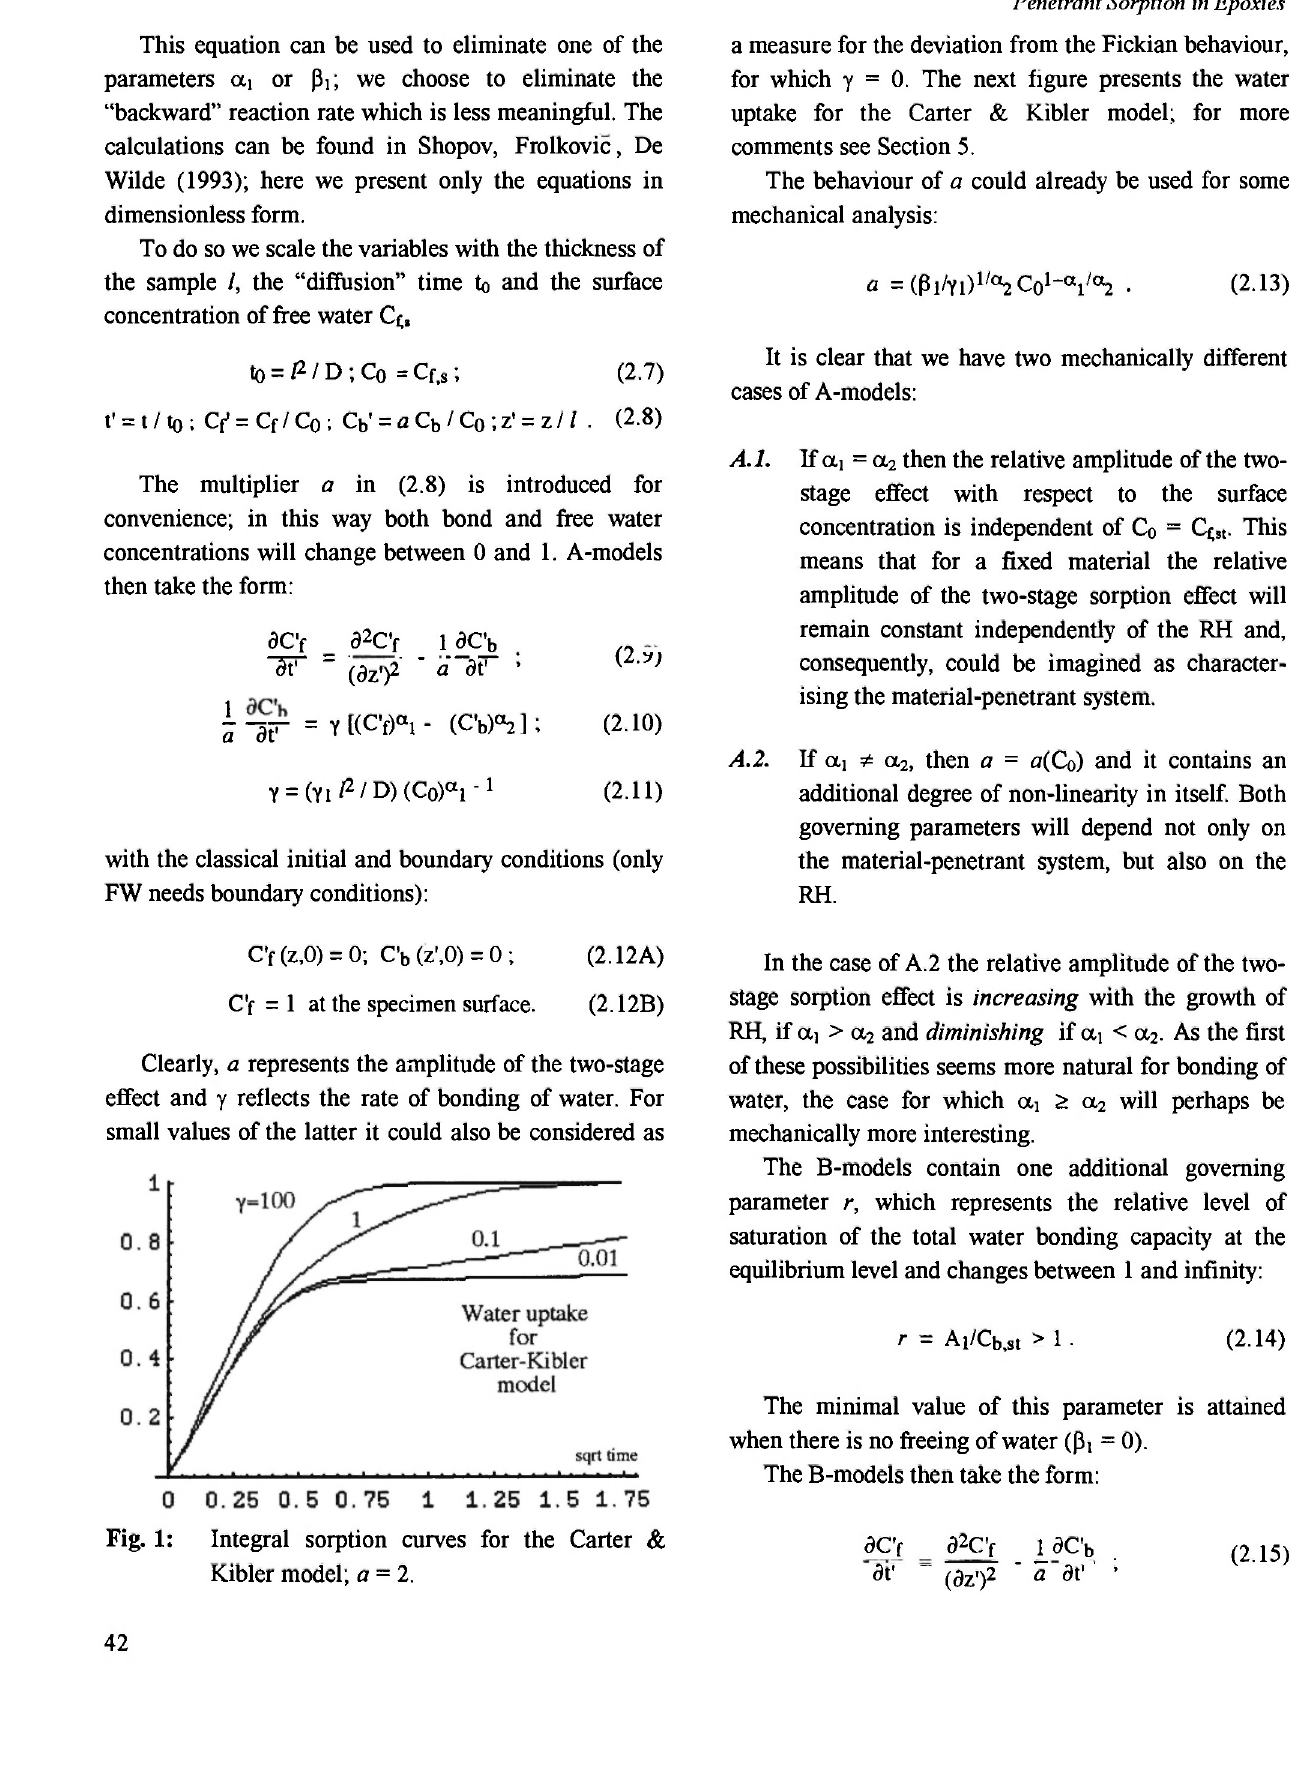
Fig. 1: Integral sorption curves for the Carter & Kibler model; a =